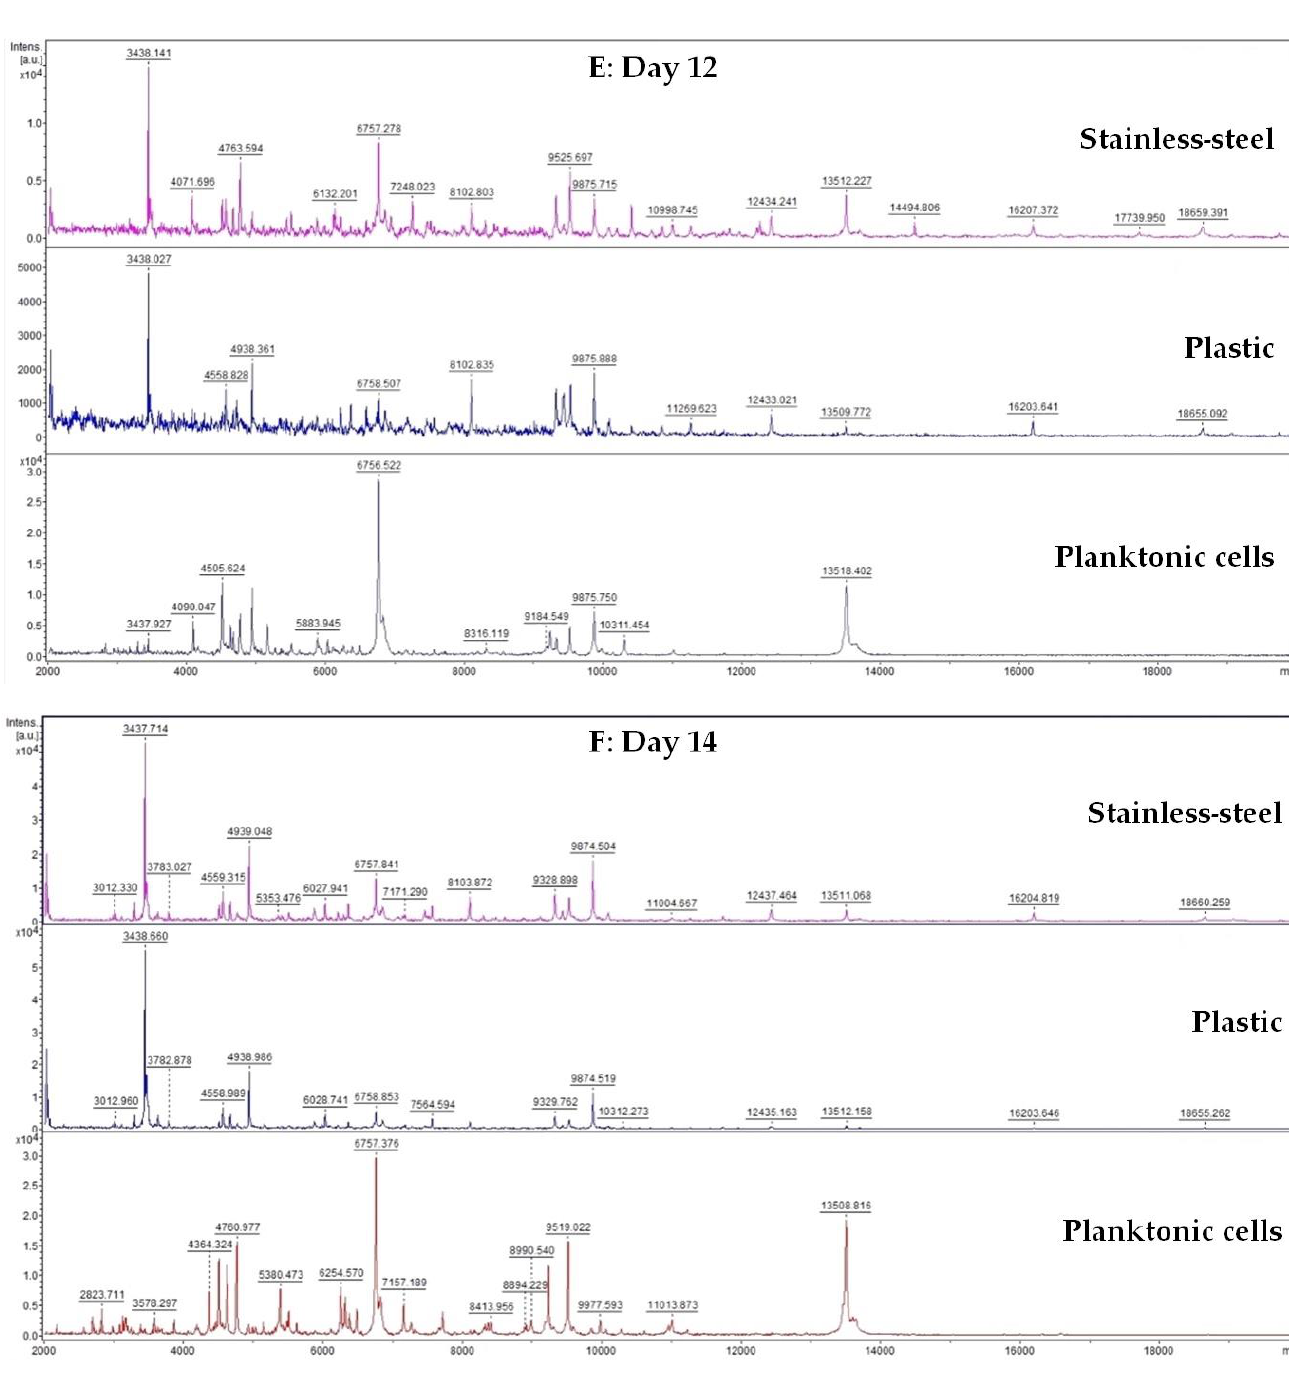
Figure 1. Changes in MALDI-TOF mass spectra of S. enterica biofilm after FEO addition: ( A ) 3rd day;